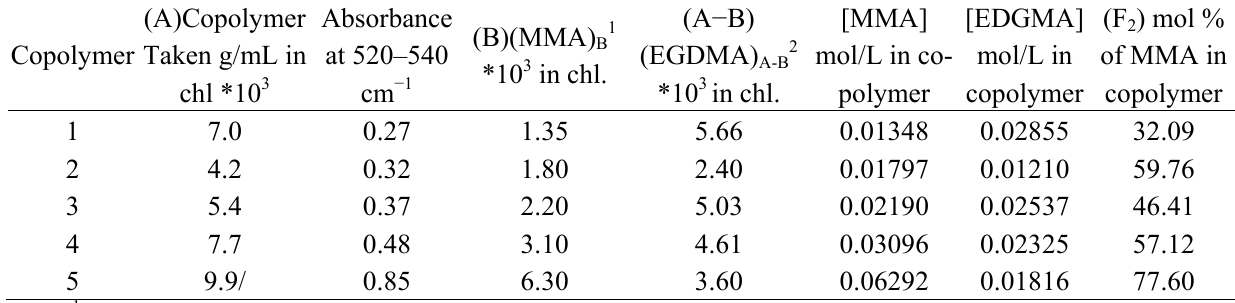
Table 2. EGDMA/MMA Copolymer Analysis (I) by IR